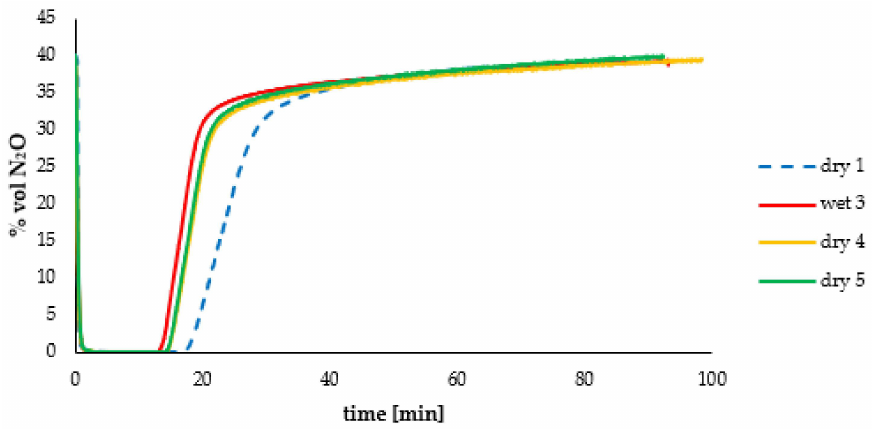
Figure 11. Wet and dry tests on the second zeolites batch compared to the first dry and wet tests (dry 1 and wet